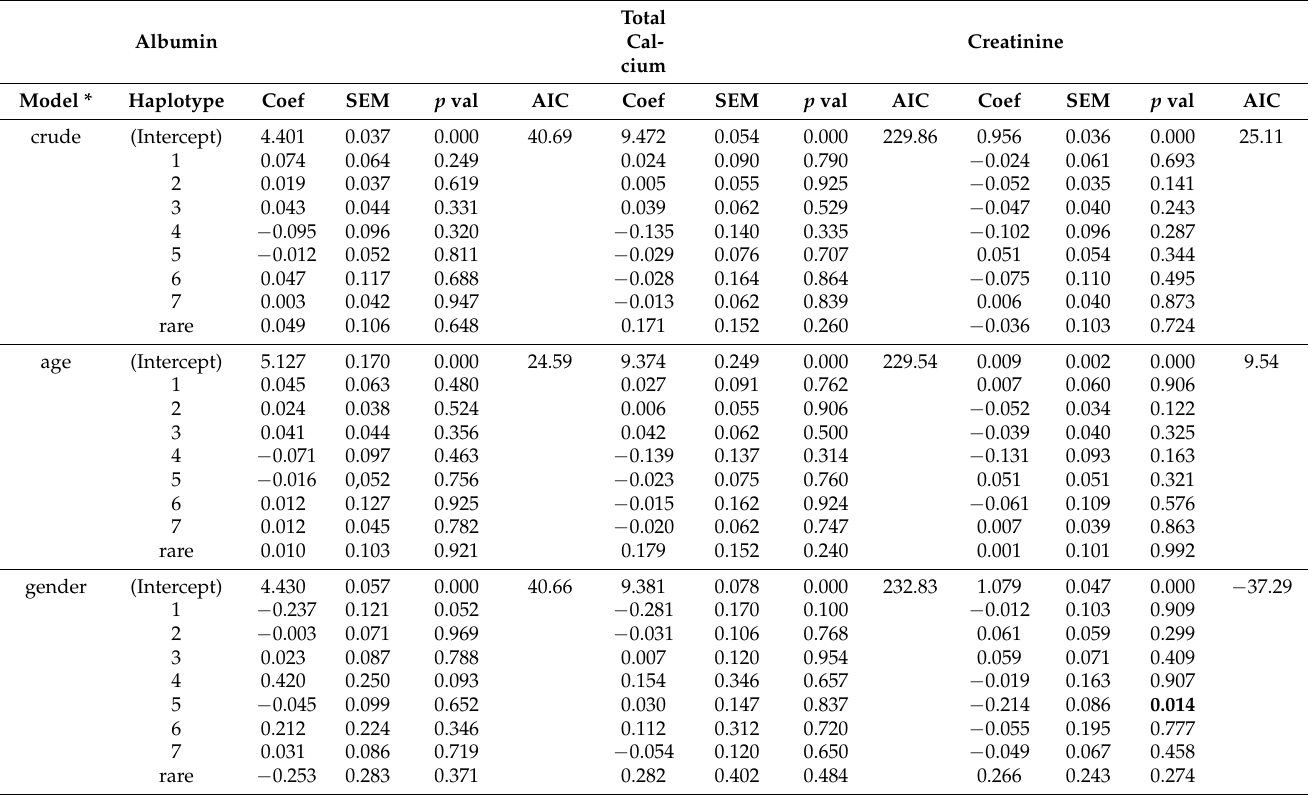
Table 7. The association of haplotypes with mineral metabolism biomarkers (Albumin, total Calcium and